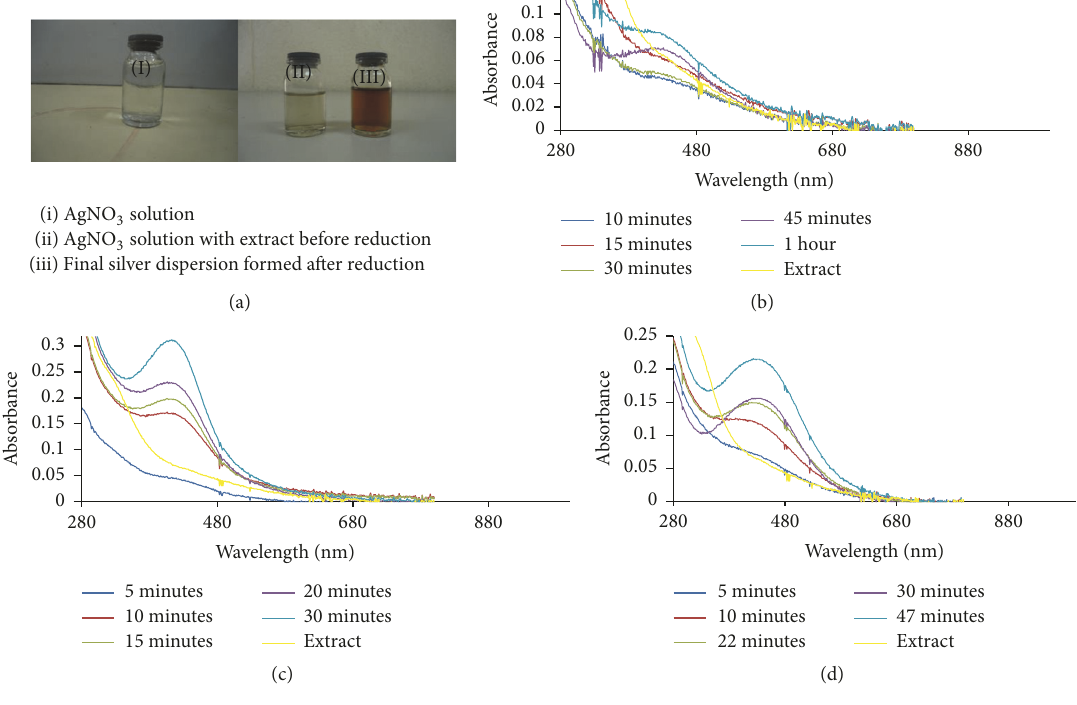
Figure 1: (a) Colour dispersion before and after nanoparticles formation, UV-Vis spectra of Ag NPs prepared by reducing (b) 0.5 mM, (c) 1.0mM, and (d) 2.0 mM precursor solutions using the extract of C. indica at 70 ∘